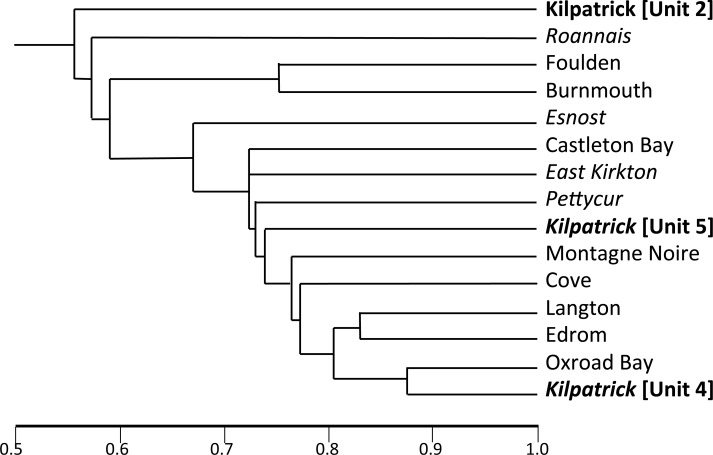
Comparative dendrogram.Bray-Curtis dissimilarity dendrogram of the spectra of putative conceptual whole-plant species reported from Mississippian lagerstätten in the Scottish Midland Valley, the Tweed Sub-basin of the Scottish Borders, and the Massif Central of south-central France. Supposedly Visean localities are italicised, unlike supposedly Tournaisian localities. The three macrofloras from the Kilpatrick Hills are highlighted in boldface.